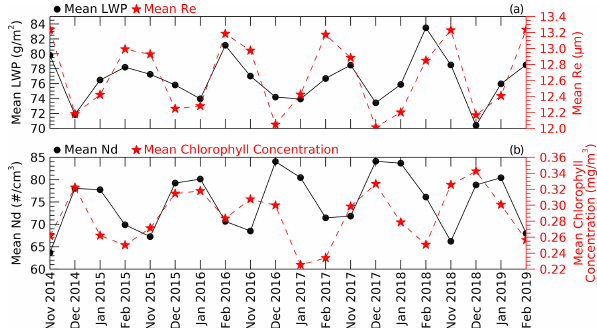
Figure 1. Monthly averaged cloud properties and chlorophyll- a (chl- a ; Hu et al., 2019) derived from MODIS data over the analy- sis domain. (a) LWP (black dots and solid line) and effective radius (Re, red star and dashed line). (b) N d (black dots and solid line) and chl- a concentration (red star and dashed